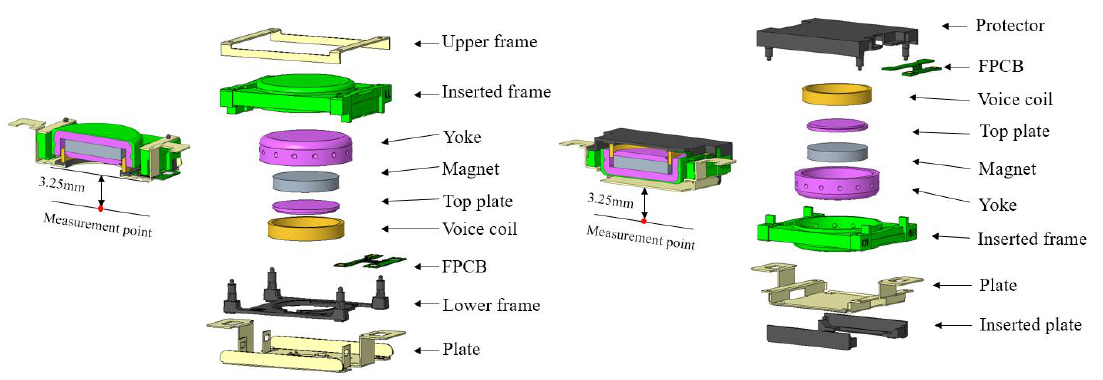
Figure 9. Structural comparison between the prototype and the second design.